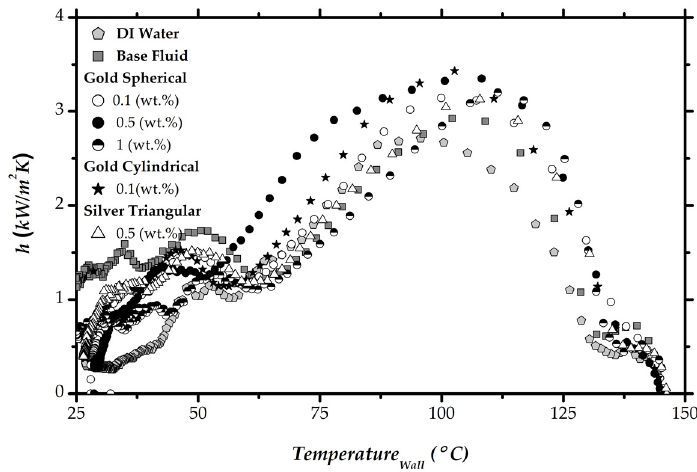
Figure 10. Heat transfer coefficient as a function of the surface temperature for the various sprays tested in the present study.